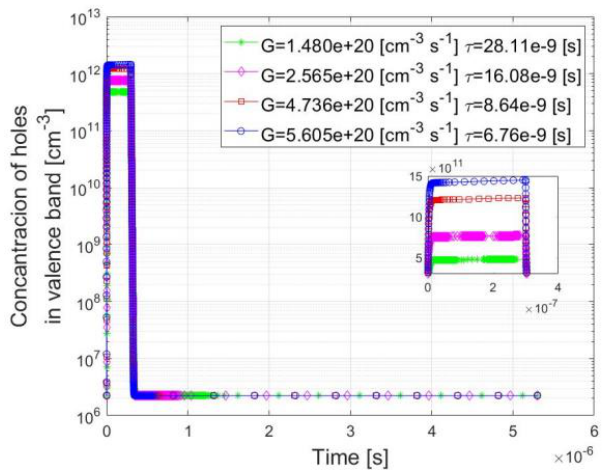
Figure 6. Changes in the concentration of holes in the valence band over time for the value of the generation coefficient corresponding to the results of experimental studies of the GaP-1 sample. The inset shows an approximation of the first 400 ns. At time zero, the lighting of the sample is turned on. Measurements carried out at a temperature of 300 K.